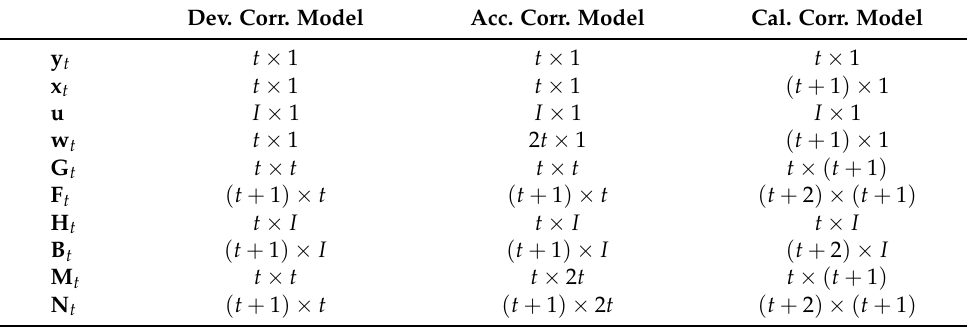
Table 6. Dimensions in the state space models of De Jong